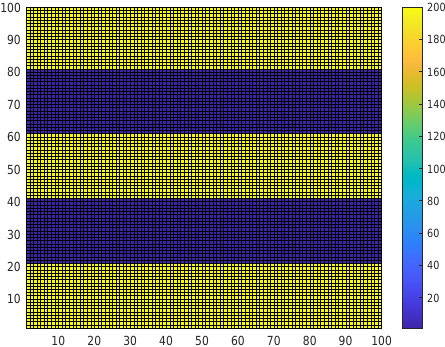
Figure 14. Permeability (md) distribution for Example